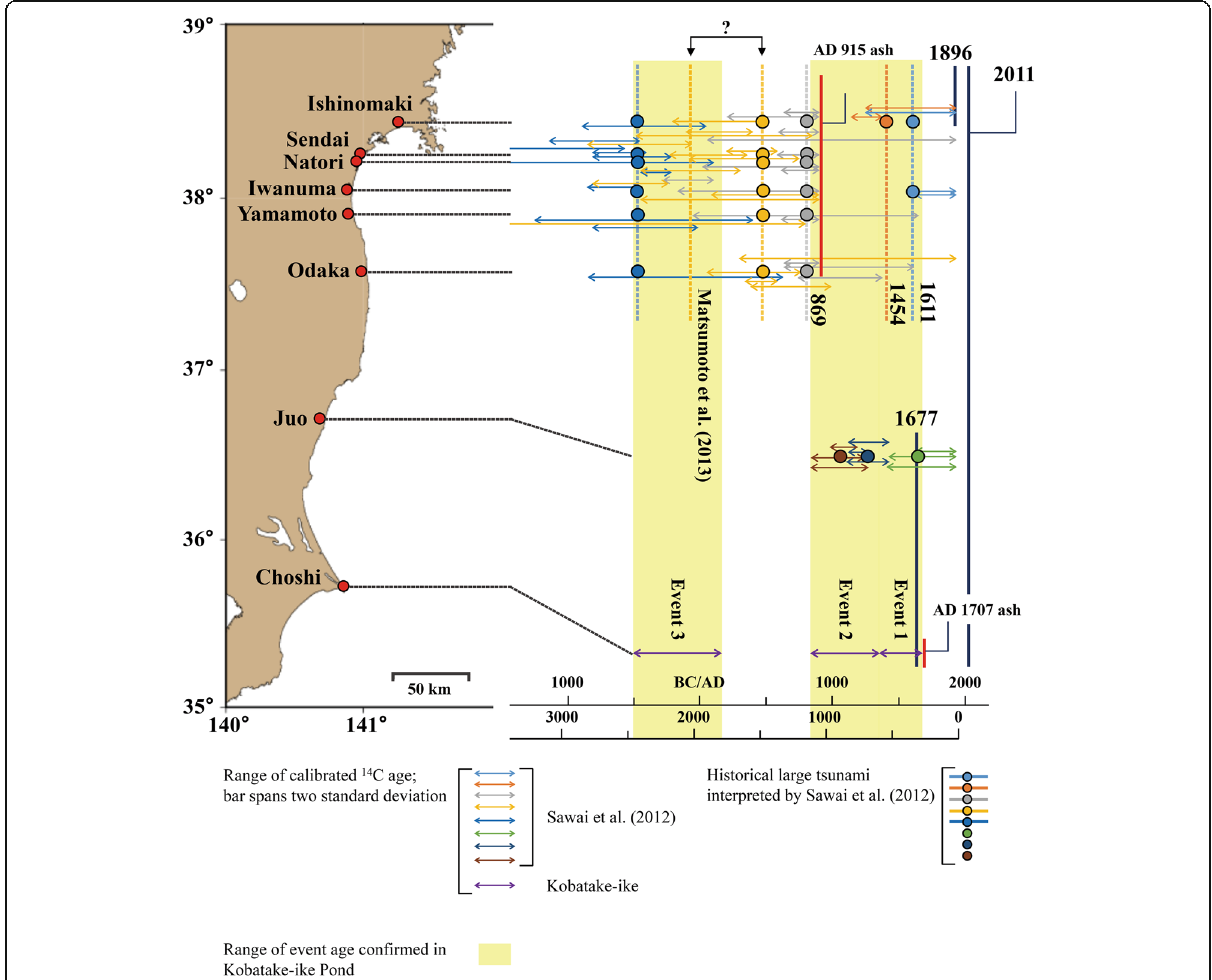
Fig. 8 Paleotsunami histories in the Pacific coasts from Miyagi to Chiba Prefecture, which faces the central and southern parts of Japan